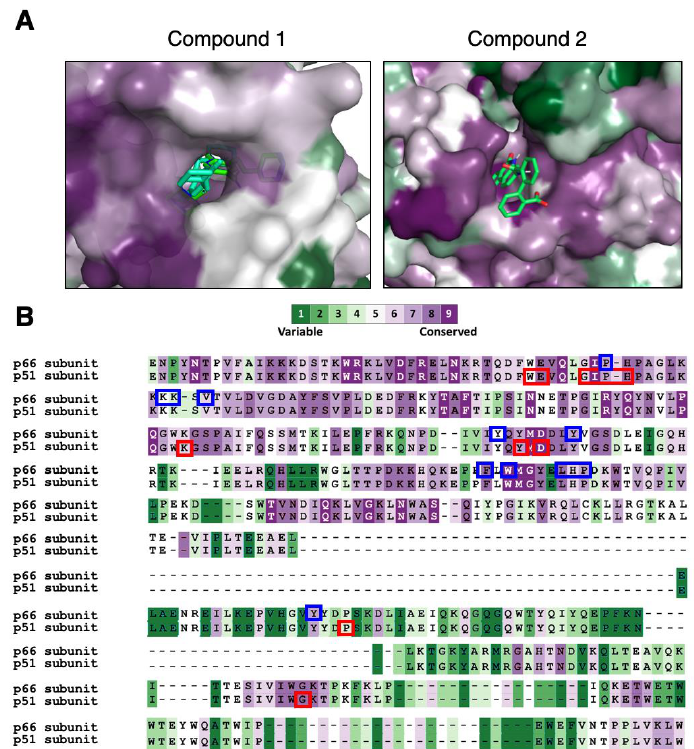
Figure 5. Two binding sites on HIV-1 RT that are highly conserved. ( A ) The binding sites on p66 and p51 complexed with compound 1 and 2, respectively, are shown in surface representation (colored according to the level of conservation among the RT families). The two potential inhibitory compounds are shown as sticks. ( B ) Sequence alignment of the binding sites on p66 and p51, for compound 1 (blue boxes) and compound 2 (red boxes). The conservation color scheme is the same as in ( A ). An animated binding of the compounds at the pockets via augmented reality can be viewed using our “ APD AR Holistic Review ” app available on both Google and Apple app stores (for more details, see Poh et al.